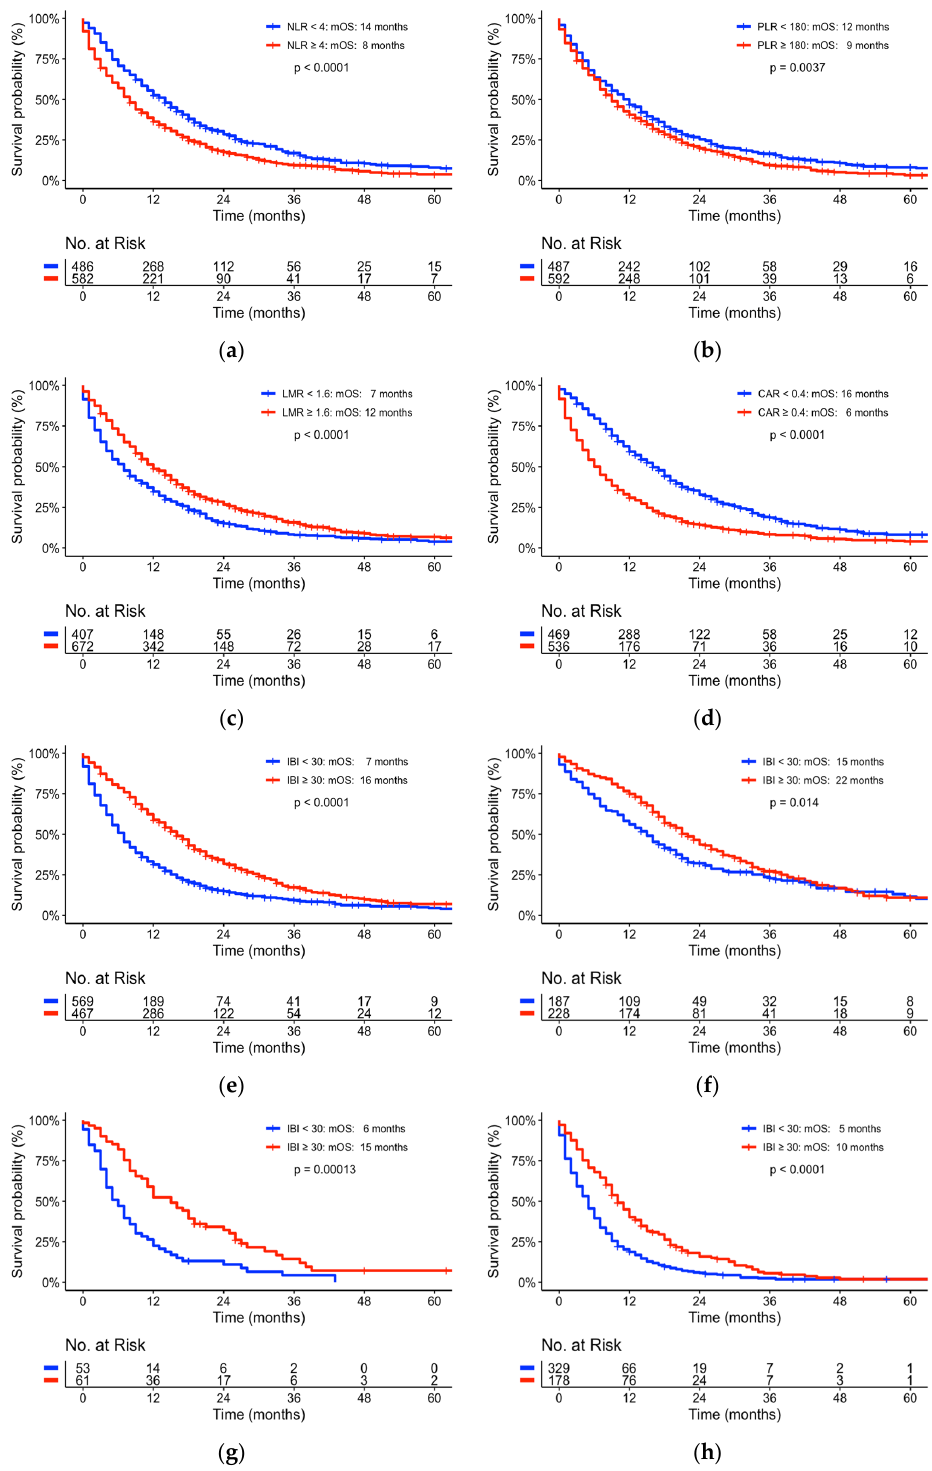
Figure 1. Kaplan–Meyer curve univariate comparison of median overall survival representing cut-off values of: ( a ) NLR = 4; ( b ) PLR = 1.6; ( c ) LMR = 180; ( d ) CAR = 0.4; ( e ) IBI = 30 for entire patient cohort; ( f ) IBI = 30 for resected patient cohort; ( g ) IBI = 30 for locally advanced patient cohort; ( h ) IBI = 30 for metastasized patient cohort. NLR—neutrophil to lymphocyte ratio; PLR—platelet to lymphocyte ratio; LMR—lymphocyte to monocyte ratio; CAR—CRP to albumin ratio; IBI—inflammatory benchmark index; mOS—median overall survival (for further subgroup analyses see Supplementary Material, Tables